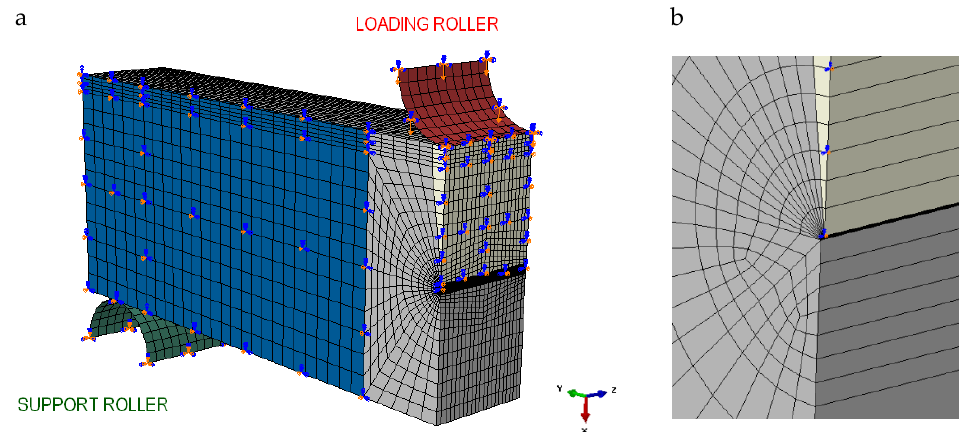
Figure 5. A mesh used in numerical modeling and calculations for the SENB specimen ( a ) and crack tip zone ( b ).